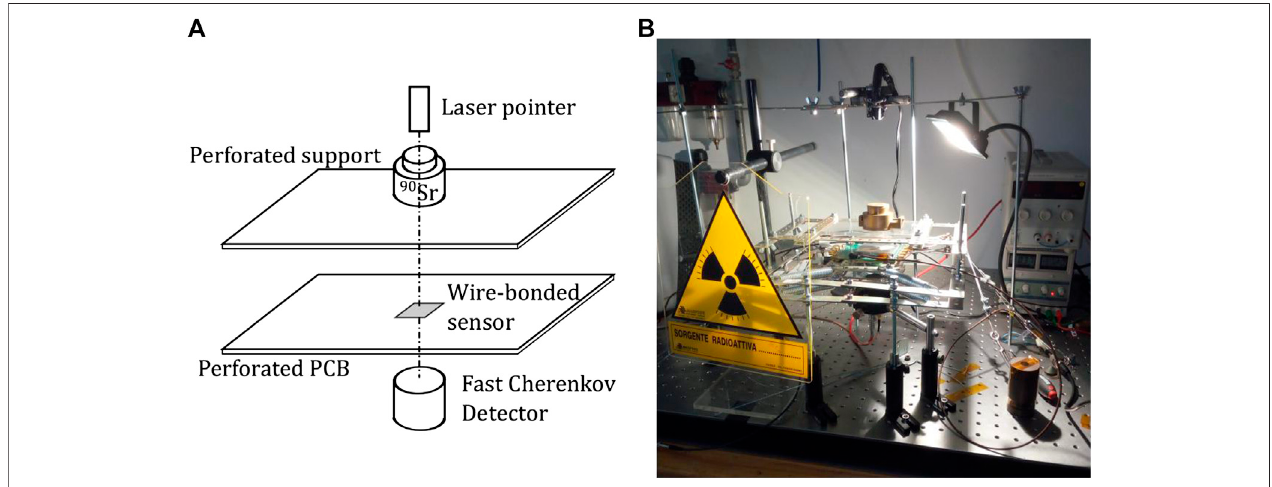
FIGURE 10 | Schematic drawing (A) and picture (B) of the experimental setup used to study the sensor response to electrons from 90 Sr.